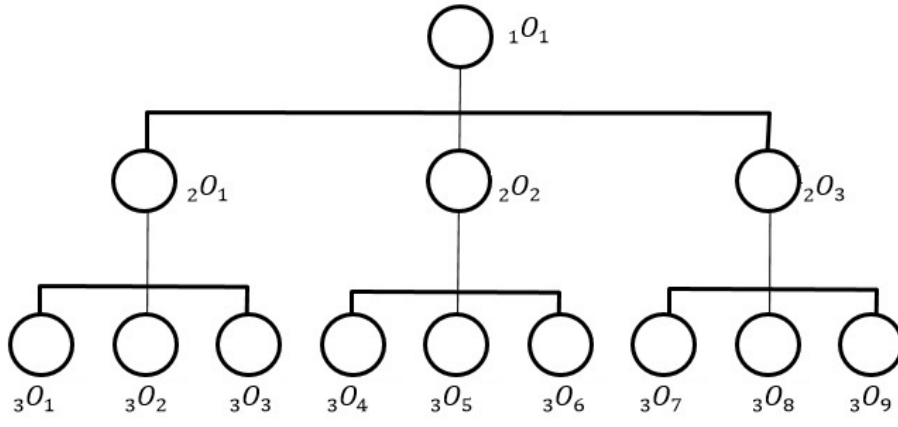
Figure 2. The control system’s